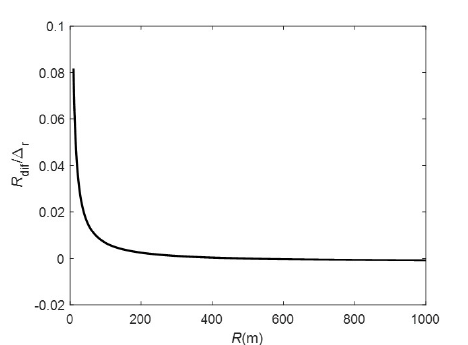
Figure 5. Differential RCM